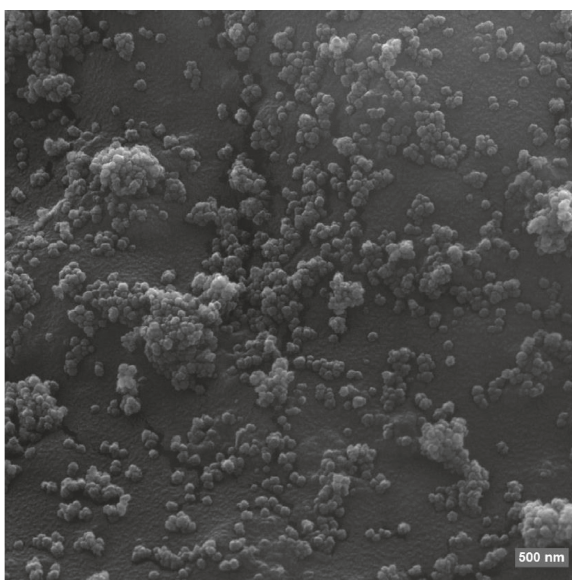
Figure 3: SEM image of magnesium oxide nanoparticles.